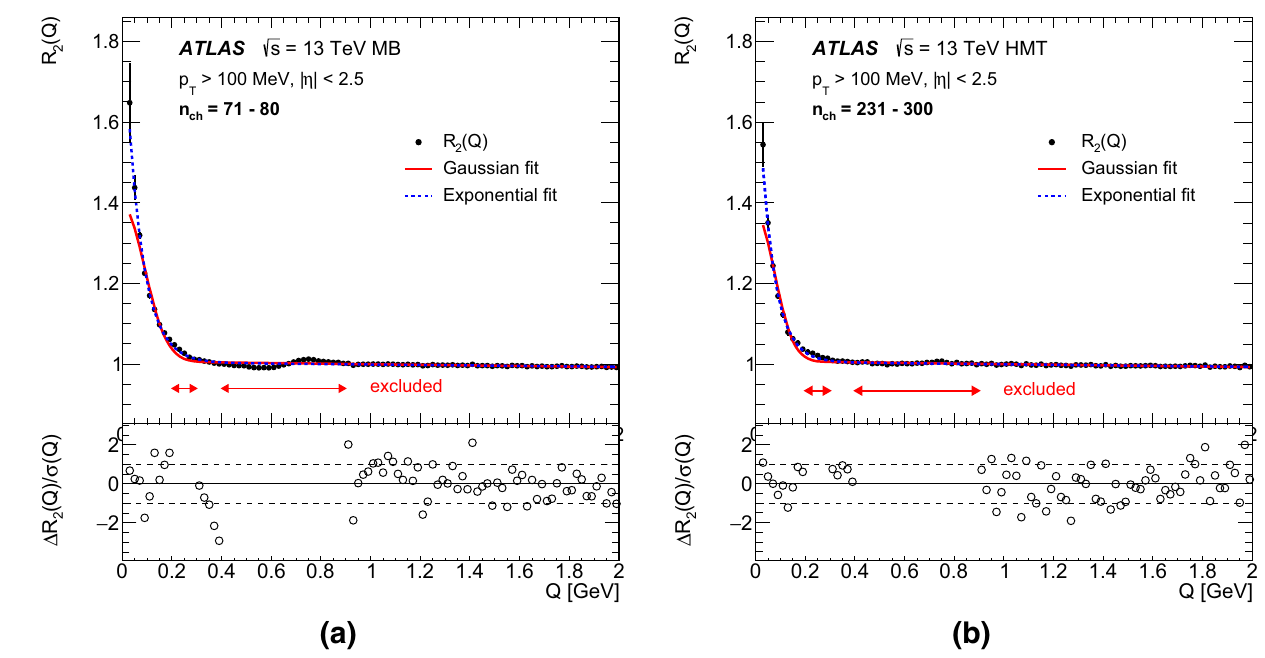
Fig. 3 Top panel: The two-particle double-ratio correlation function, from the fits is shown. The statistical uncertainty and the systematic √ R 2 ( Q ) , for pp collisions for track p T > 100 MeV at s = 13 TeV uncertainty for imperfections in the data reconstruction procedure are added in quadrature. Bottom panel: The difference between the experi- in the multiplicity intervals a 71 ≤ n ch < 80 for the minimum-bias mental R 2 ( Q ) function and the result of the exponential fit normalized (MB) events, and b 231 ≤ n ch < 300 for the high-multiplicity track (HMT) events. The blue dashed and red solid lines show the results to the experimental uncertainty, (cid:13) R 2 ( Q )/σ( Q ) , is of the exponential and Gaussian fits, respectively. The region excluded